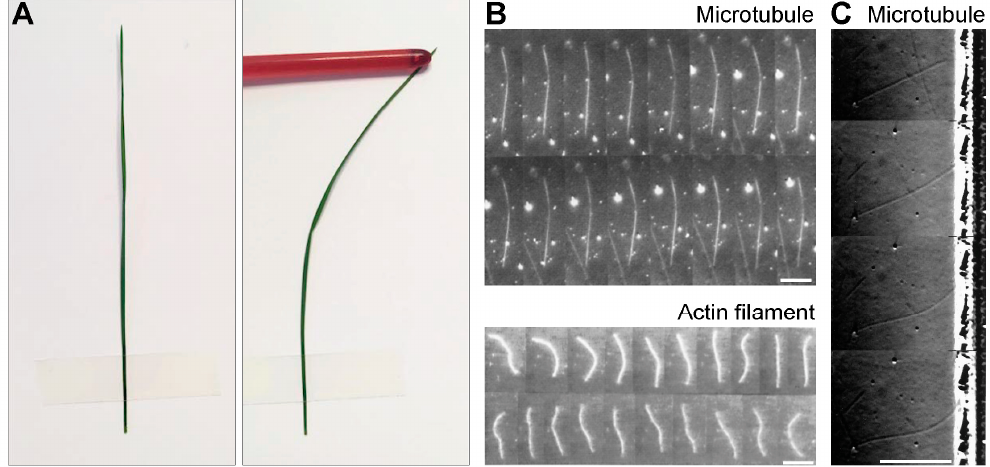
Figure 2. From forces to shapes and back. ( A ) A macroscopic example of a plant stem illustrates the fact that microtubules are intrinsically straight, but can curve under forces. ( B ) Time-lapse images of a microtubule (top; images are separated by 10 s) and an actin filament (bottom; images are separated by 1.5 s) undergoing thermal fluctuations in curvature. The scale bars represent 10 µ m. The curvature fluctuations of the microtubule are small due to its high rigidity. The images are reproduced with permission from [17]. ( C ) Images of a buckling microtubule encountering a wall (separated by 1 min). Scale bar, 10 µ m. The images are reproduced with permission from [18].